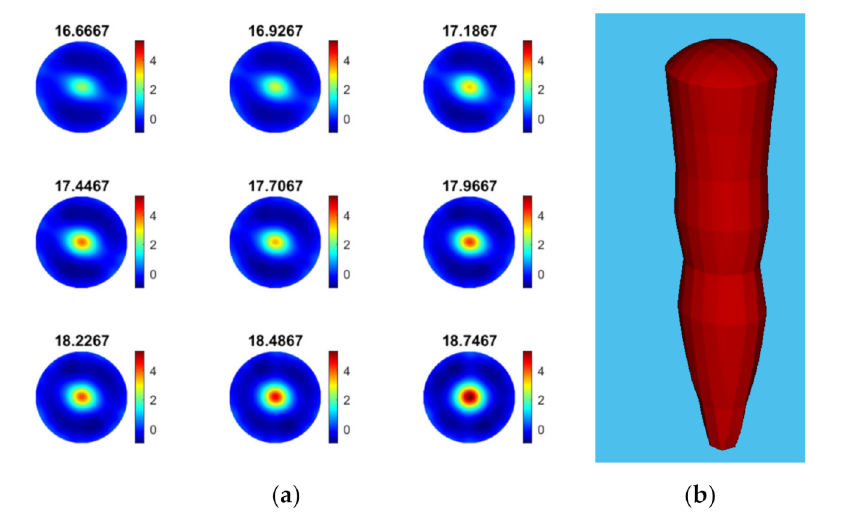
Figure 13. ( a ) Image reconstruction for amplitude attenuation for the same time windows as Figure 9. ( b ) Reconstructed volume depicting the growth of dispersed